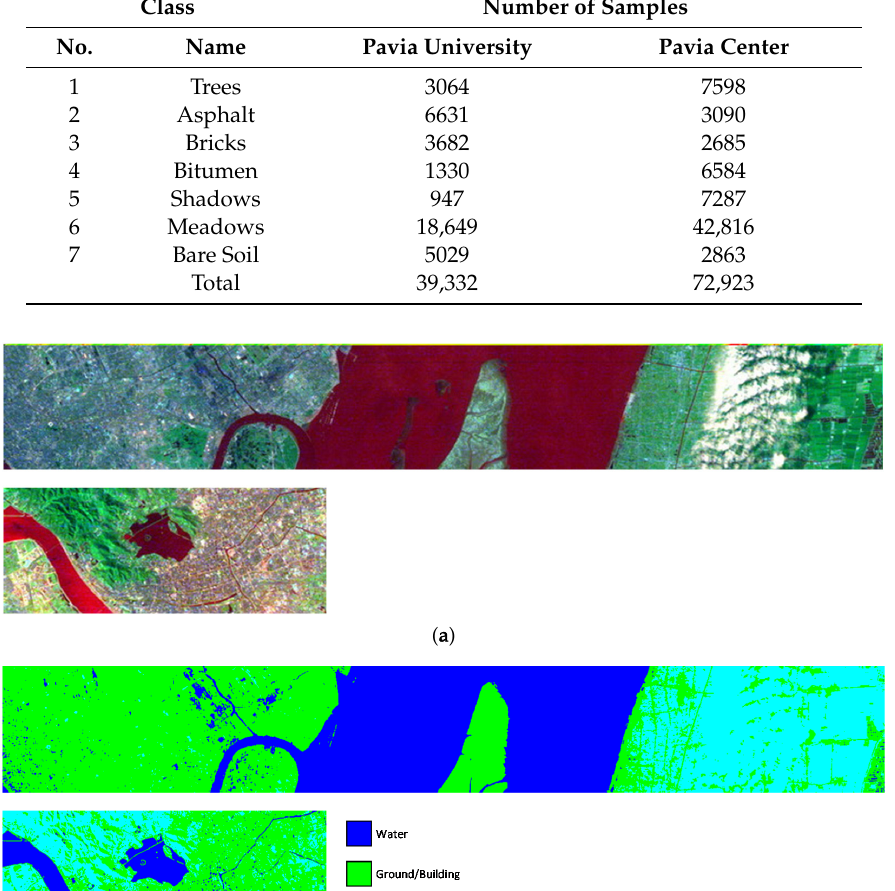
Figure 4. (a) False-color image of Pavia Center dataset. (b) Ground truth of Pavia Center dataset. Figure 4. ( a ) False-color image of Pavia Center dataset. ( b ) Ground truth of Pavia Center dataset. Table 2. Land cover classes and the number of samples for Pavia University–Pavia Center.